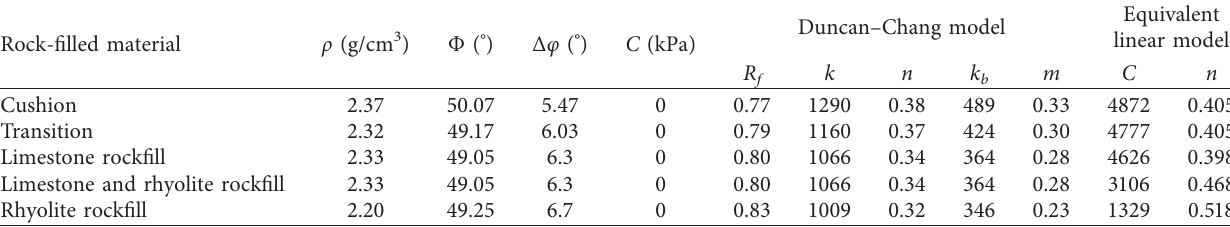
Table 2: Static and dynamic parameters of the Houziyan Dam.